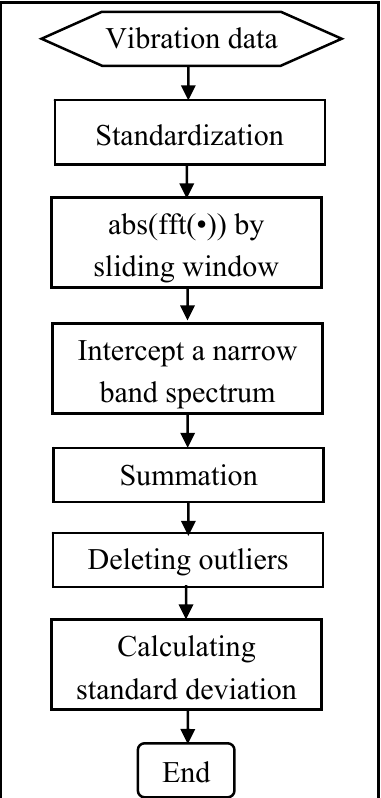
Figure 5. Feature extraction